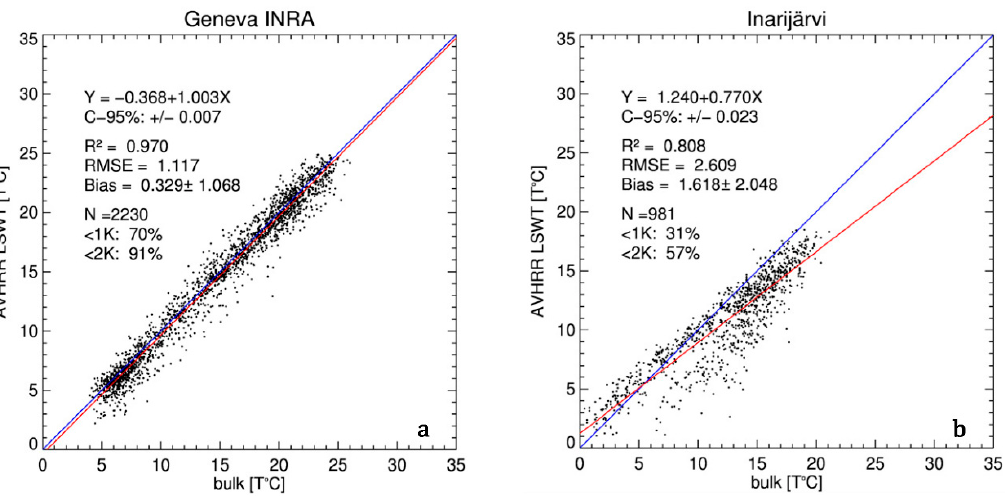
Figure 8. The validation with daily in-situ measurement at Lake Geneva, INRA ( a ) and Inarijärvi ( b ). The validation at Lake Geneva INRA shows good performance and a high number of matchups through the whole year. At Inarijärvi, however, the weakest validation performance of all is found. Inarijärvi is located north of the polar cycle and has a long period of ice cover per year. Further, the in-situ measurement station is located within a very complex shore geometry with many small islands.